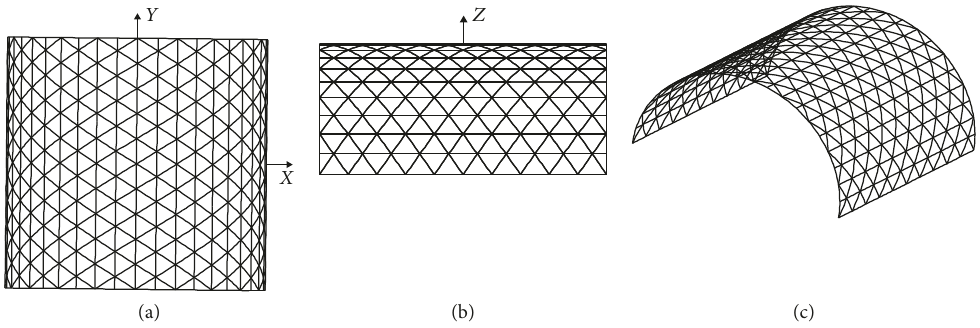
Figure 8: Analysis model: a single-layer reticulated cylindrical shell. (a) Top view. (b) Lateral view. (c) 3D